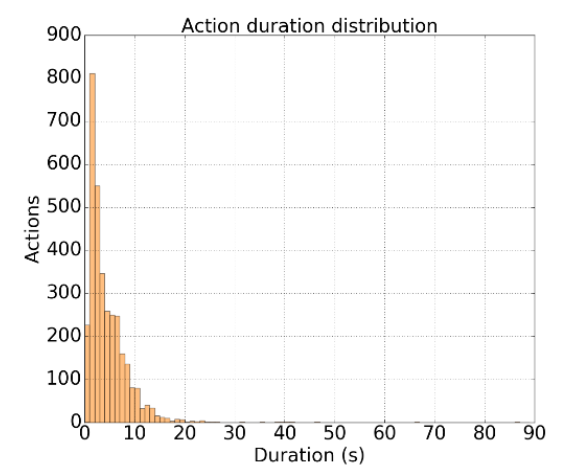
Figure 9. Ditribution of the duration of the actions in